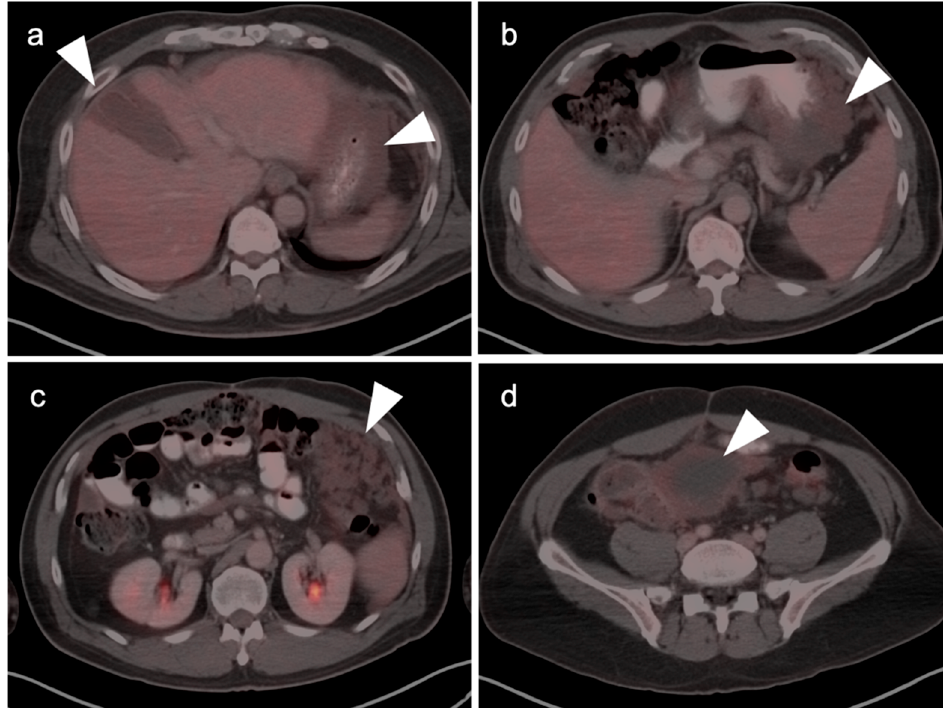
Figure 32. Pseudomyxoma peritonei shown on multiple axial fused FDG PET-CT images. Spillage or seeding of mucinous material from either mucinous cystadenomas or cystadenocarcinomas of the pancreas (as well as breast, ovary, colon and appendix) can result in gelatinous ascites (white arrowheads) that will spread and grow throughout the abdomen. Shows is a case with ( a ) Mucinous material in the gallbladder fossa and implanted on the stomach ( a , b ); ( c ) Infiltrating mucinous implants caking the omentum; and ( d ) Mass-like mesenteric implants.